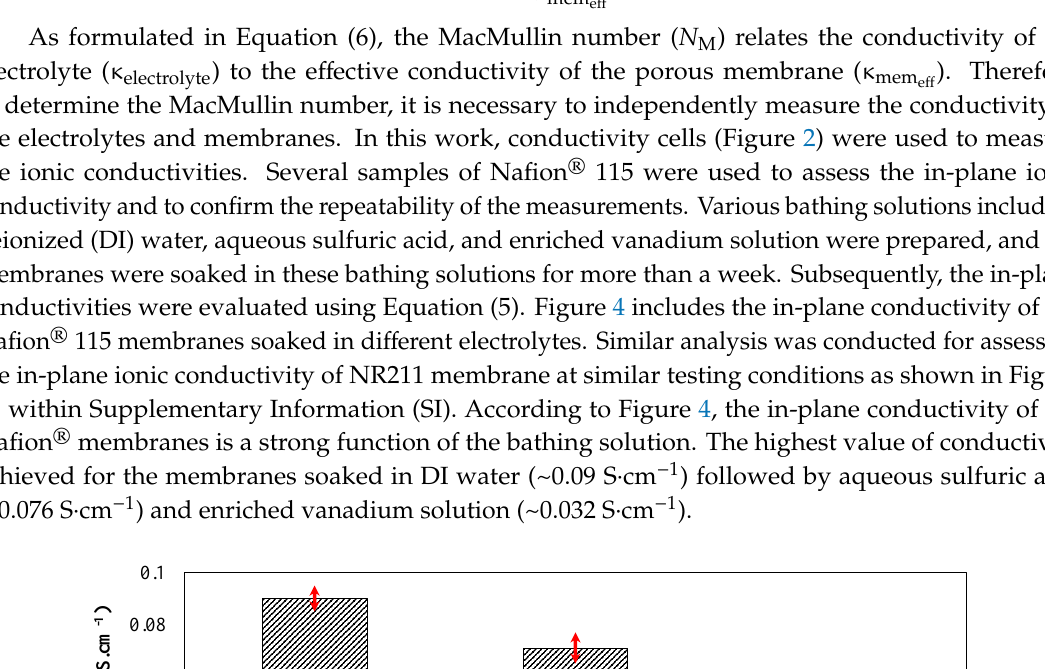
Table 1. Area-specific resistance (ASR) for series of Nafion ® 115 membranes.